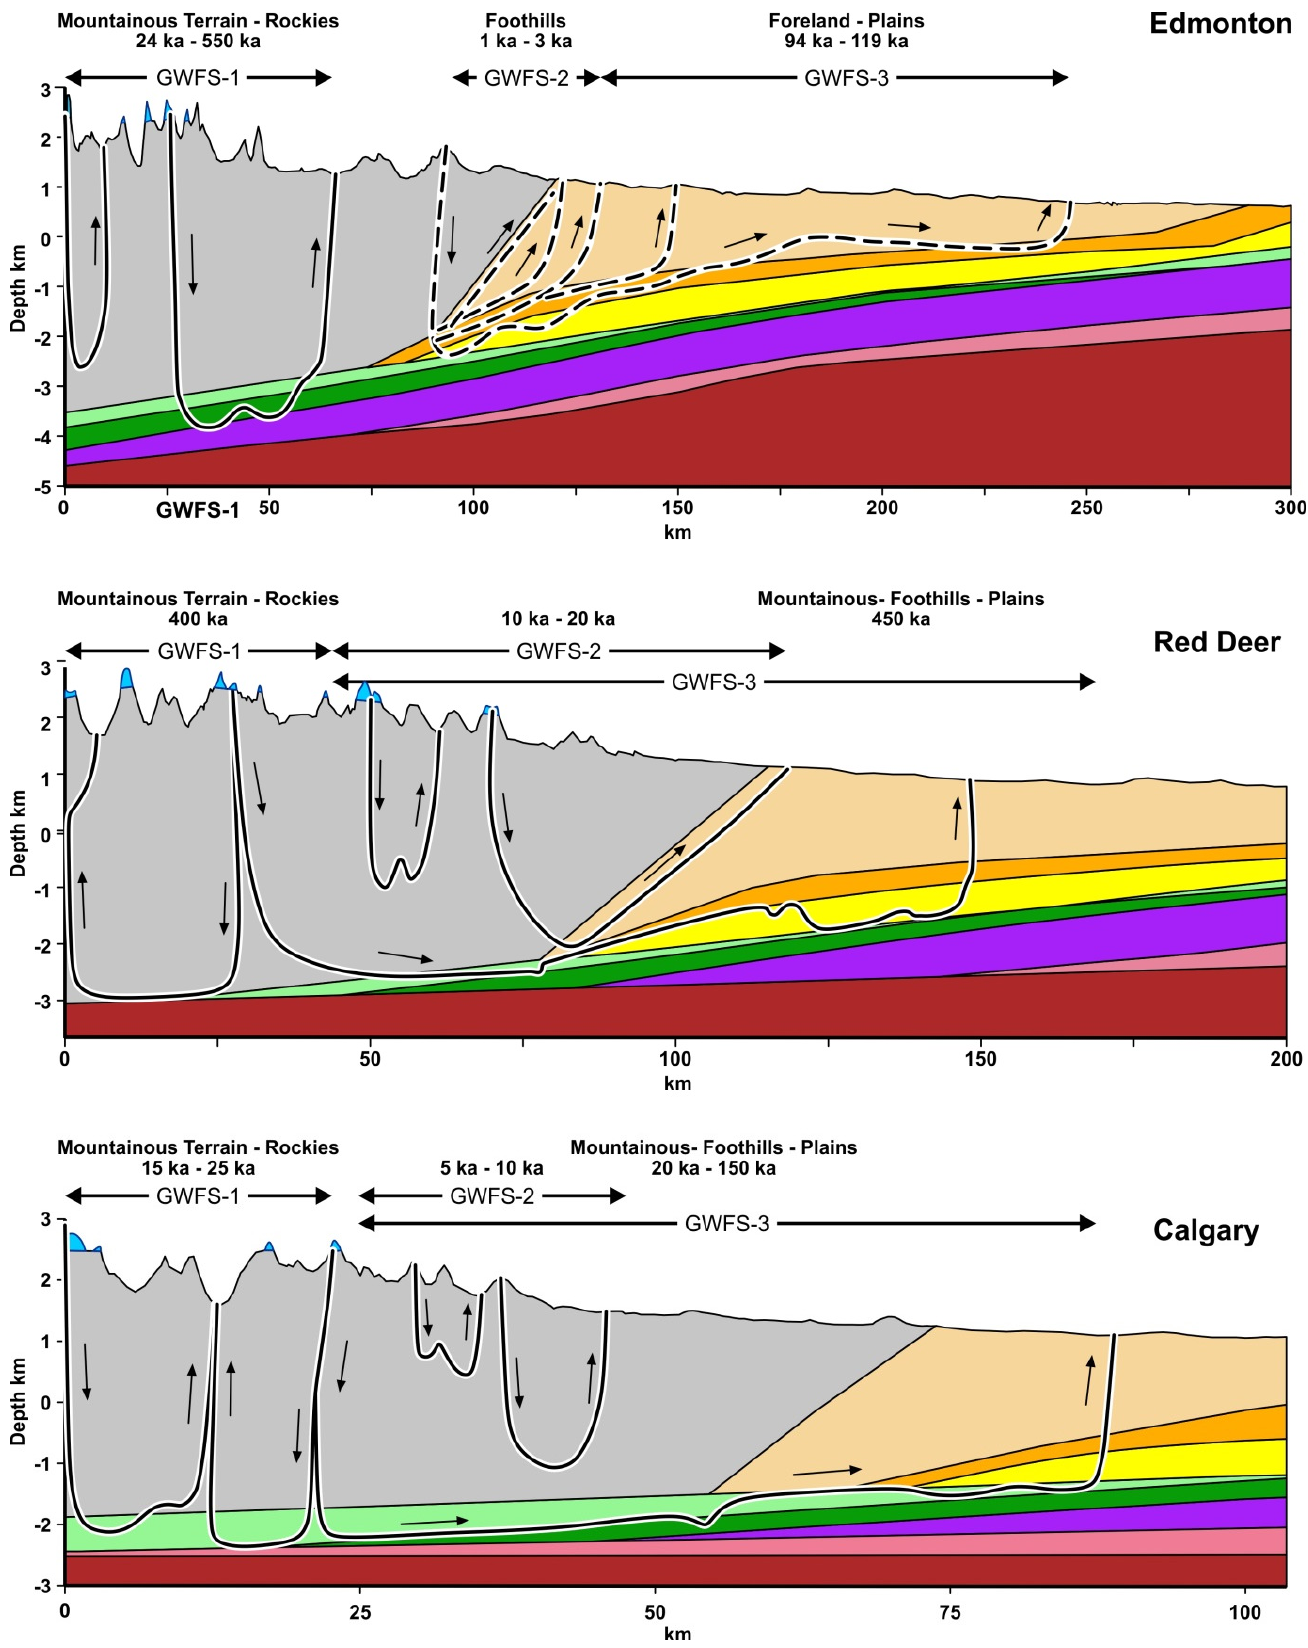
Figure 18. Groundwater flow systems for the three models.